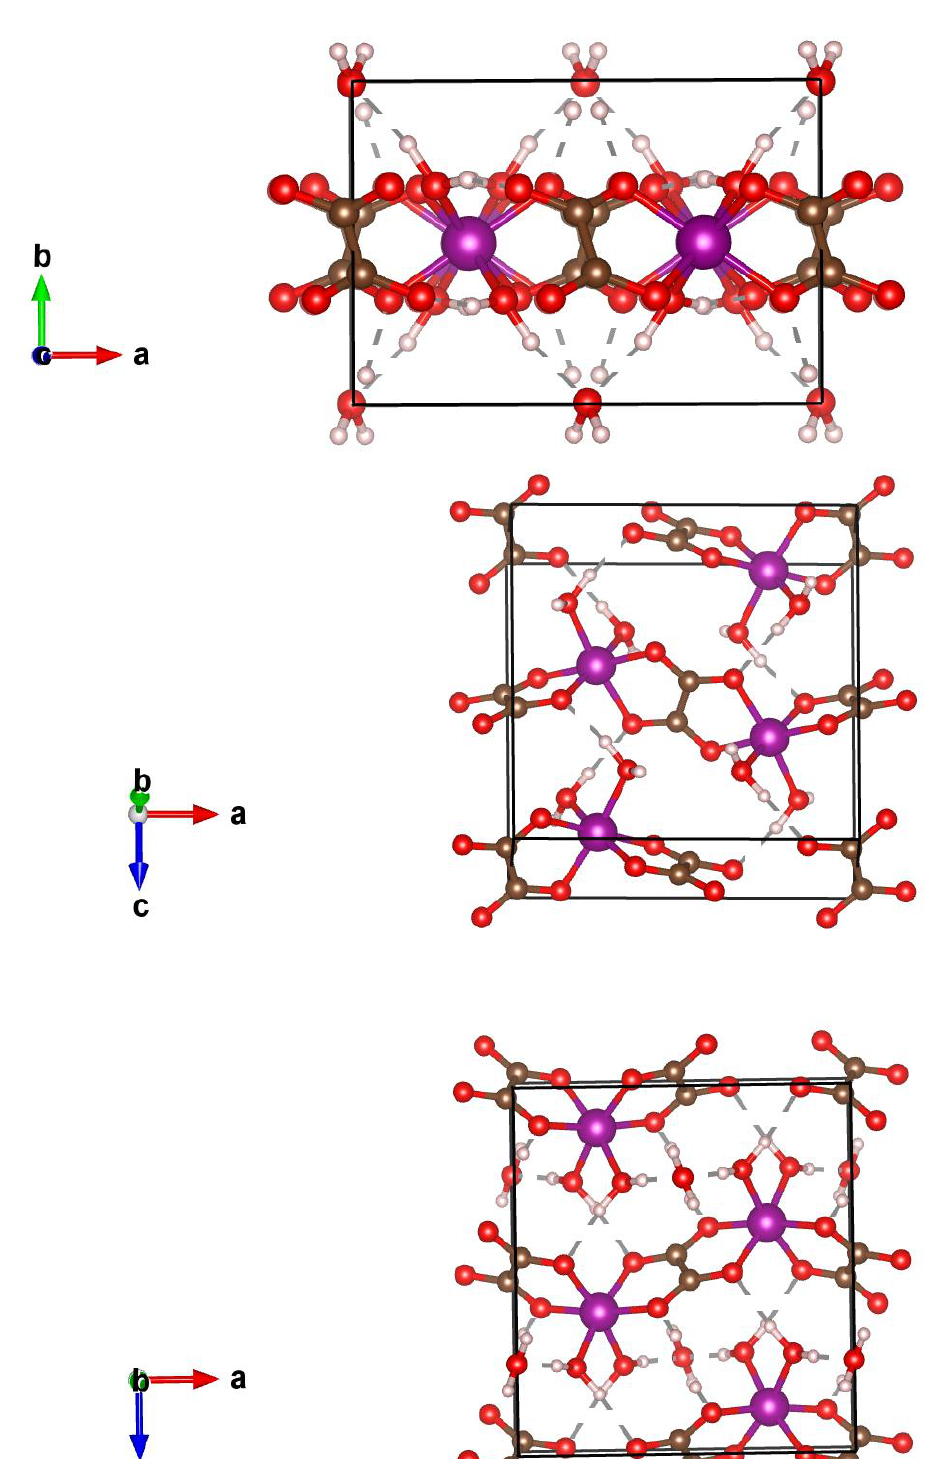
Figure 3: Water molecules distribution.